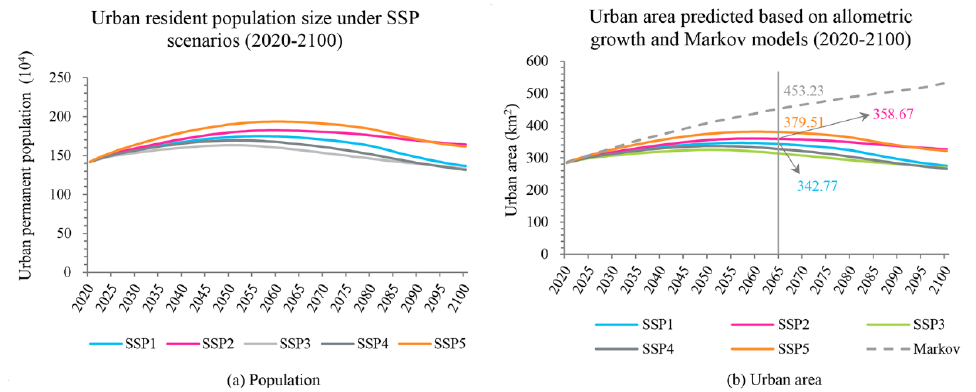
Figure 4. Predicted population size and urban area in Jinjiang City from 2020 to 2100 under the di ff erent SSP scenarios.